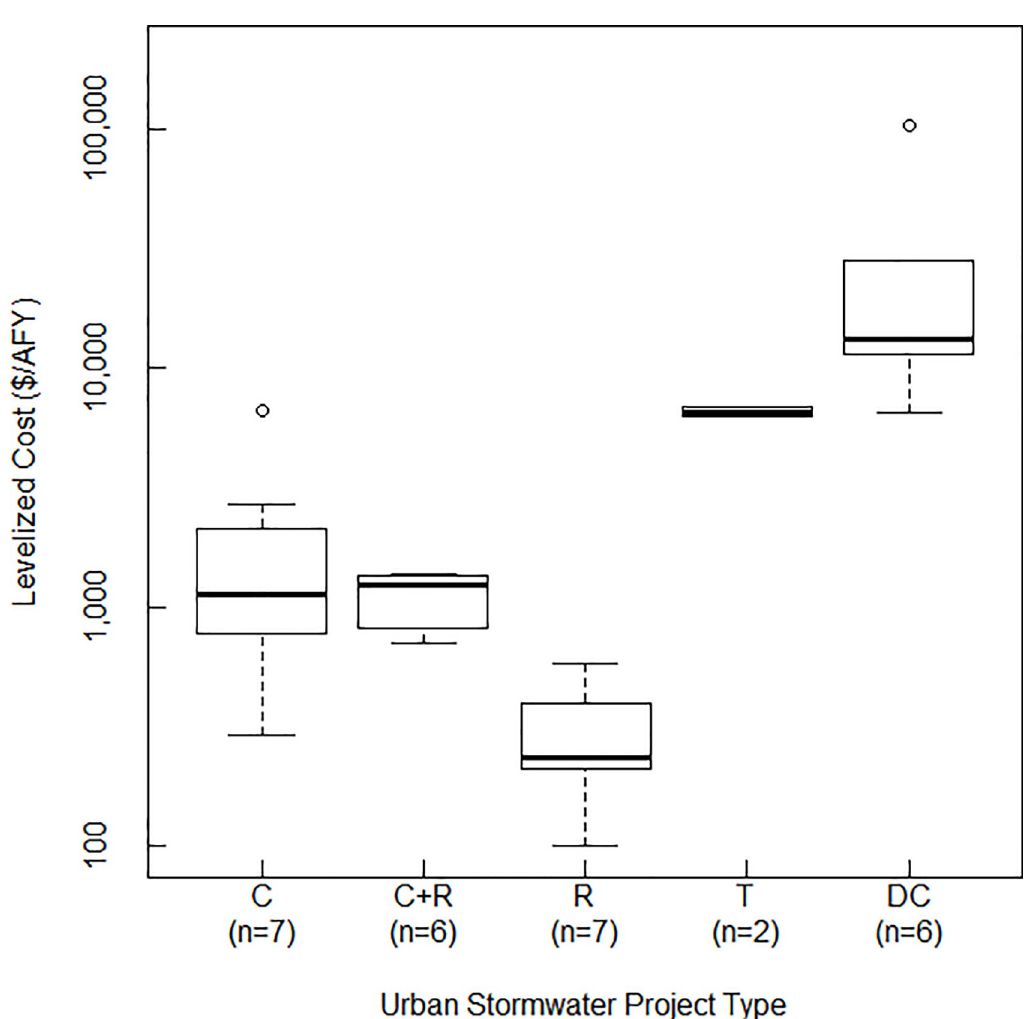
Fig 4. Boxplot of levelized cost of water ($/AFY) for five types of urban stormwater capture project types: Conveyance (C), conveyance and recharge (C+R), recharge (R), treatment (T), and decentralized